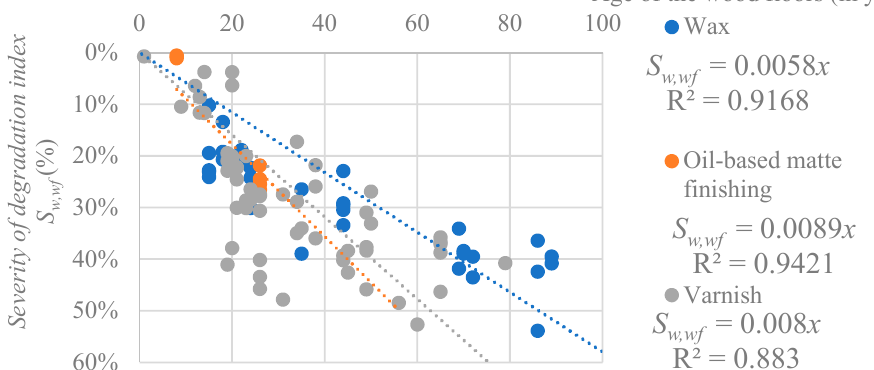
Figure 7. Regression analysis between the numerical index that expresses the degradation of the 96 wood flooring systems ( S w,wf ) and their age, according to the surface coating.